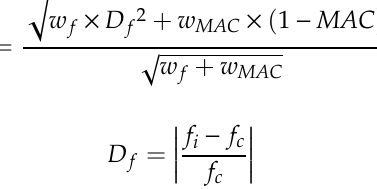
Figure 7. The results of the candidate mode of modal frequency 2.03 Hz at each step: ( a ) after the 1st step with the largest similarity coefficient in every dataset selected; ( b ) after the 2nd step with the ones with MAC ≥ 0.8 left; ( c ) after the 3rd step with the MAC fulfilling the Tukey’s fence criterion; and ( d ) after the 4th step with the modal frequency fulfilling the Tukey’s fence criterion.